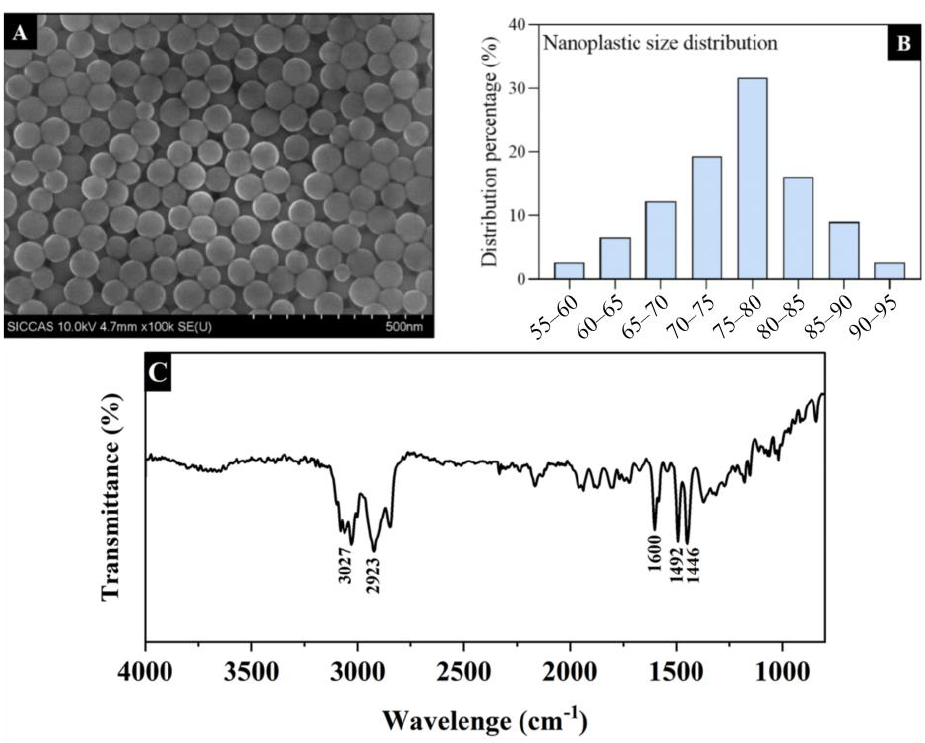
Figure 1. Transmission electron microscopy image of polystyrene (PS) nanoplastic ( A ). Particle size distribution of nanoplastics ( B ). The average nanoplastic diameter was 76 ± 7 nm (mean ± SD, n = 150). FTIR spectrum of PS nanoplastic ( C ).